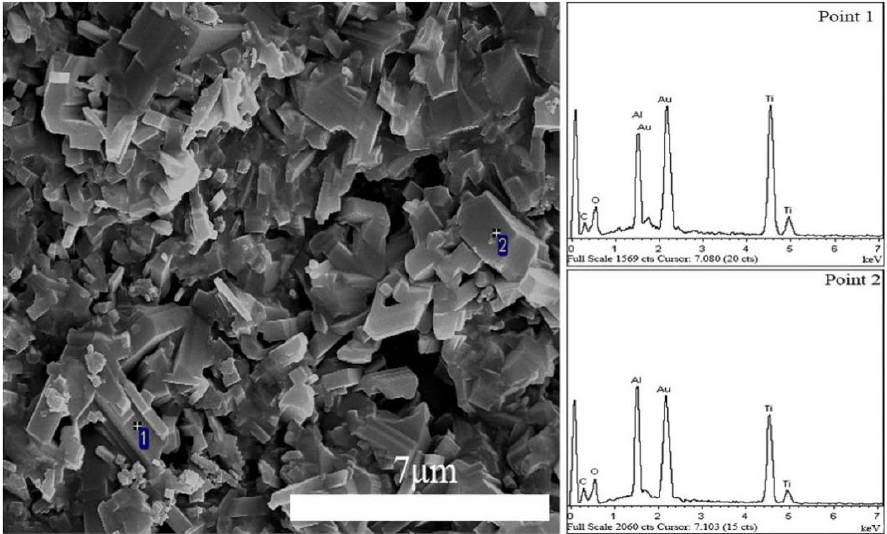
Figure 5. EDS analysis of TSC50 after oxidation at 1400 °C for 4 h.